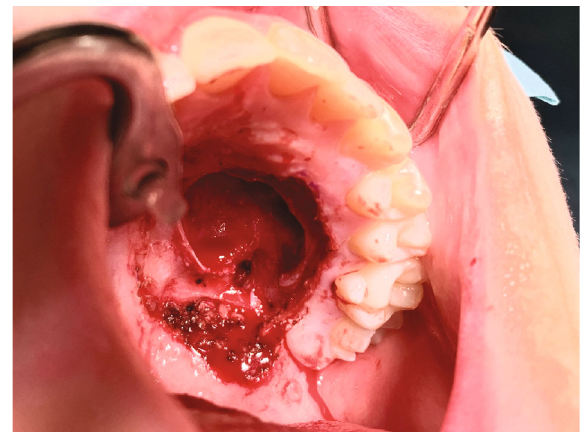
Figure 4: Image of the palatal defect after tumor resection.